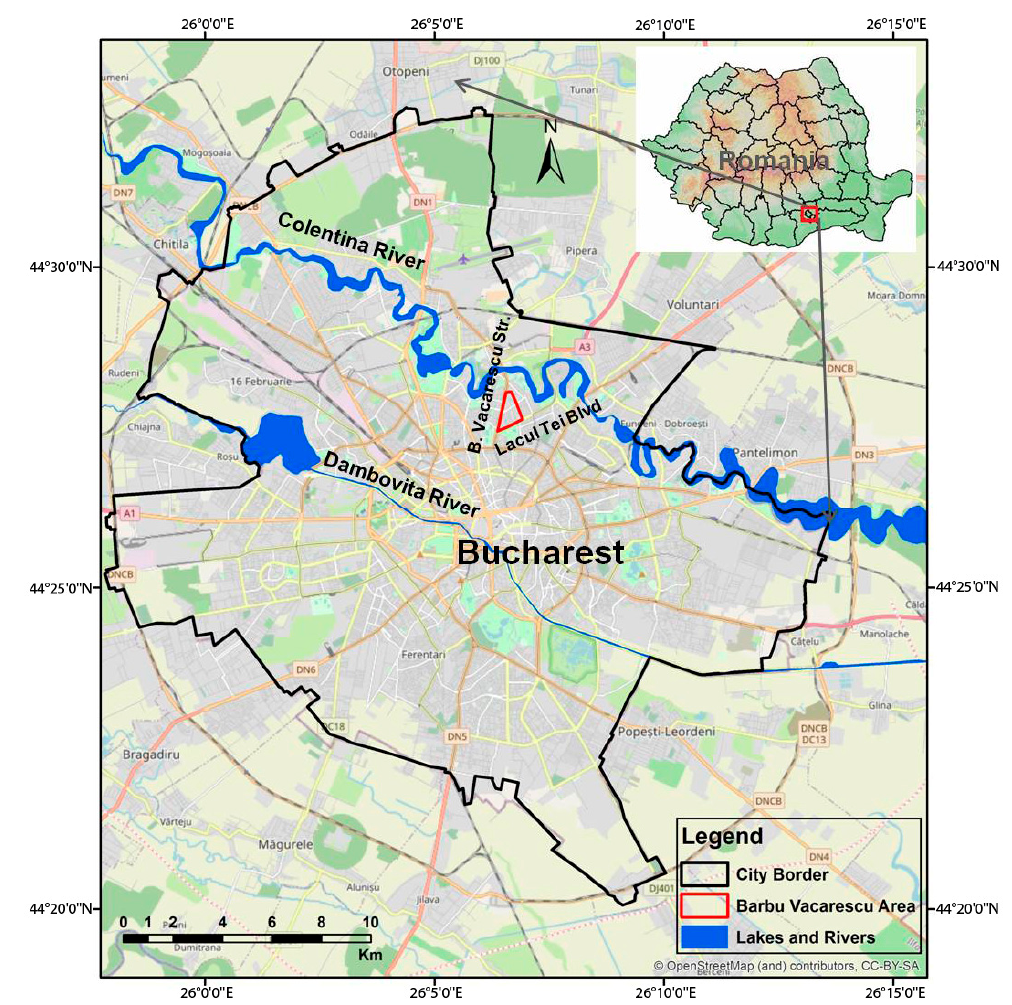
Figure 1. Bucharest map. Barbu Vacarescu Area is outlined in red. Map generated in Esri ® ArcMap ™ 10.3. Base map source: OpenStreetMap.